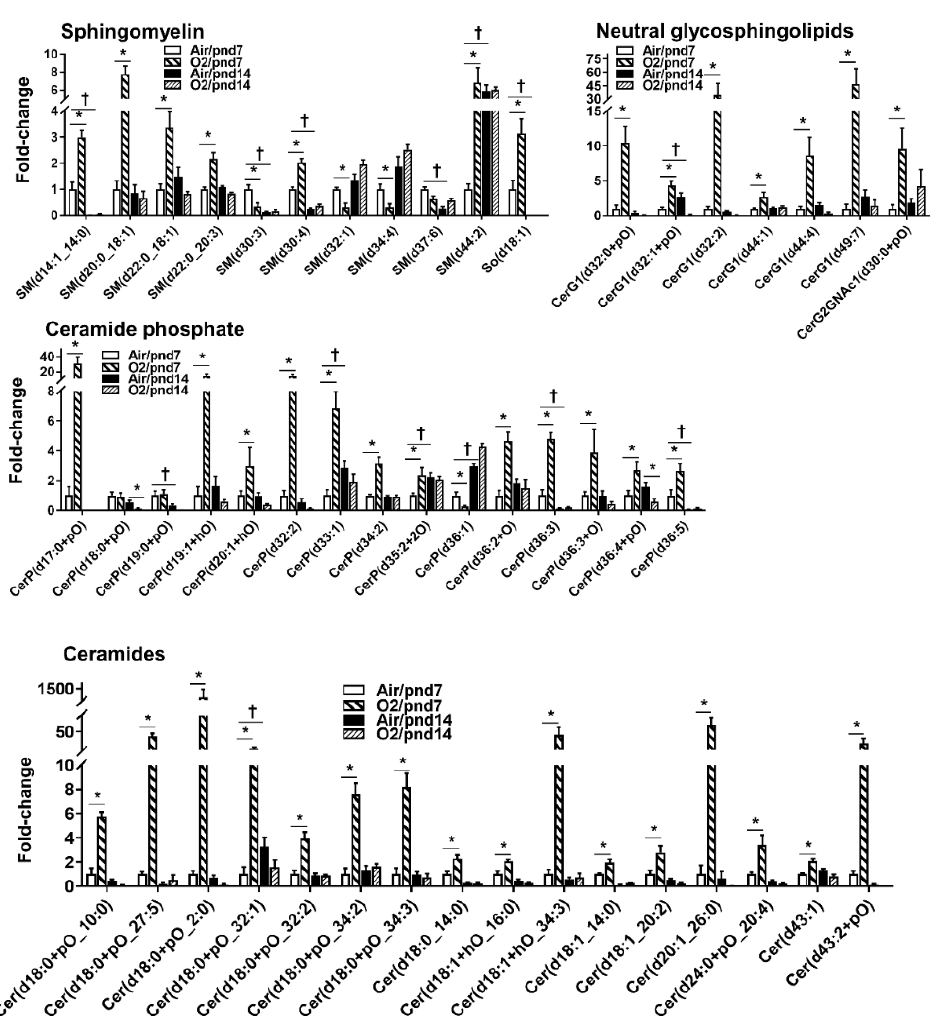
Figure 8. Compositional changes of lung sphingolipid species in mice exposed to hyperoxia as neonates. SM, CerP, neutral glycosphingolipid, and Cer species in mouse lungs with 2-fold change and p < 0.05 between air and hyperoxia groups at pnd7 and pnd14 were listed. n = 6. * p < 0.05 vs. corresponding air; † p < 0.05 vs. air/pnd7 .